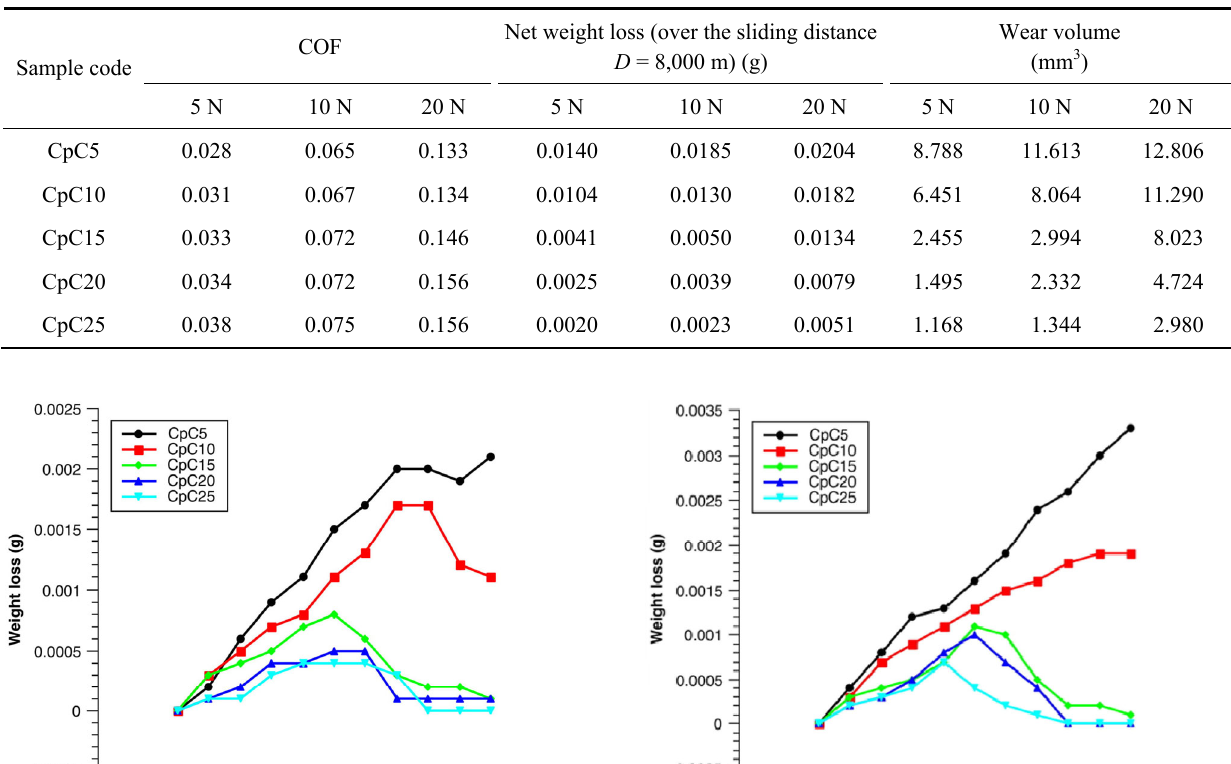
Table 2 Detailed tribo-characteristic of composites at different loads of 5, 10, and 20